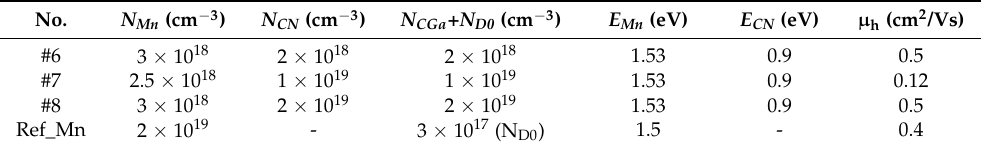
Table 4. The parameters used for the solution of the charge neutrality equation (Equations (1)–(3)) in order to fit experimental data presented in Figure